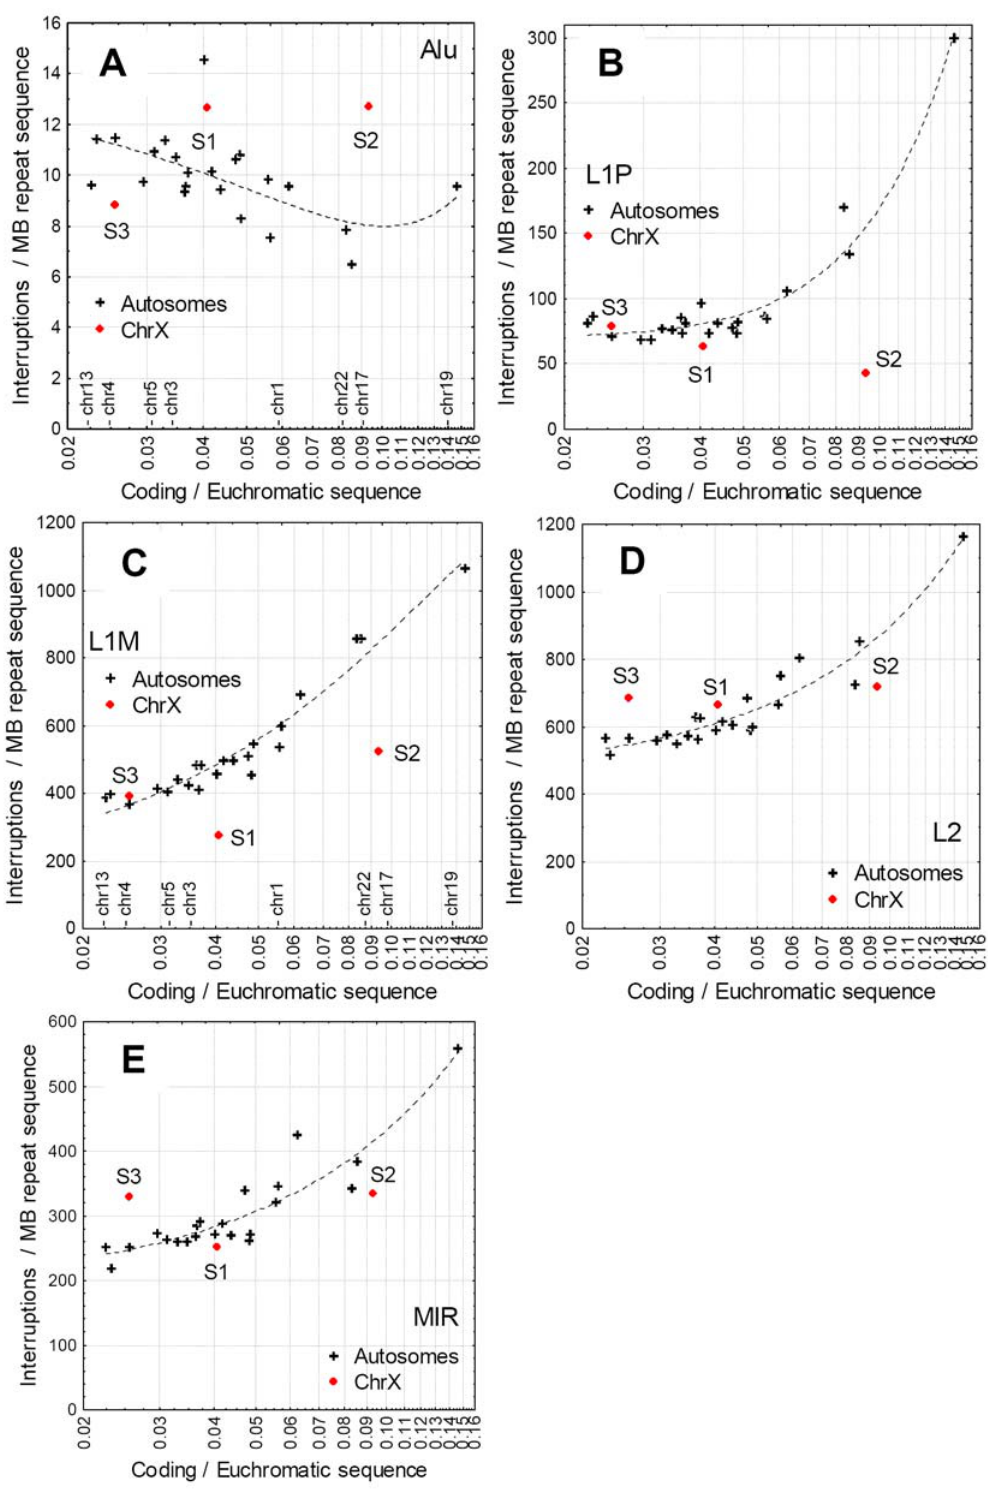
Figure 4. Correlations between the density of coding sequence in the euchromatic region of chromosomes (coding sequence/non- repetitive sequence), and the frequency of interruptions of the main non-LTR repeats. The positions of selected chromosomes are indicated on the x-axis on panels A and C. Note the logarithmic X axis. Each cross represents an autosome, the three strata (S1–S3) of the X chromosome that contain the most inactivated genes are shown in red. With the exception of Alus, repeats are interrupted more frequently on gene dense chromosomes, and unlike L1s, other non-LTR repeats do not show a depletion of interruptions in the S1–S3 strata.